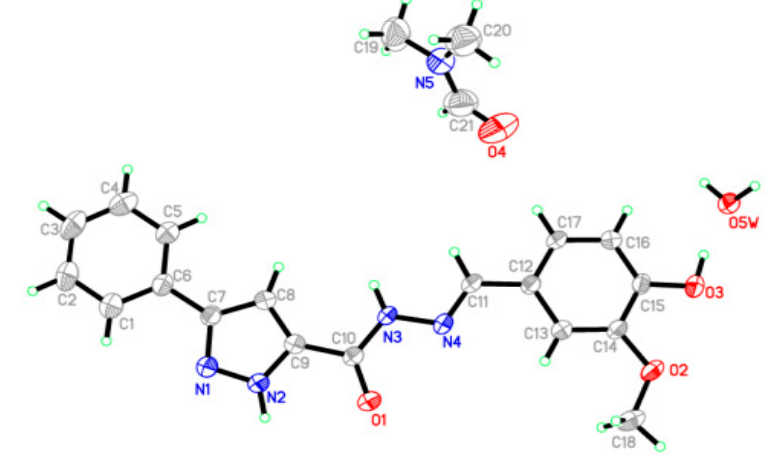
Figure 1. Asymmetric unit of L1 (CCDC 1522882).